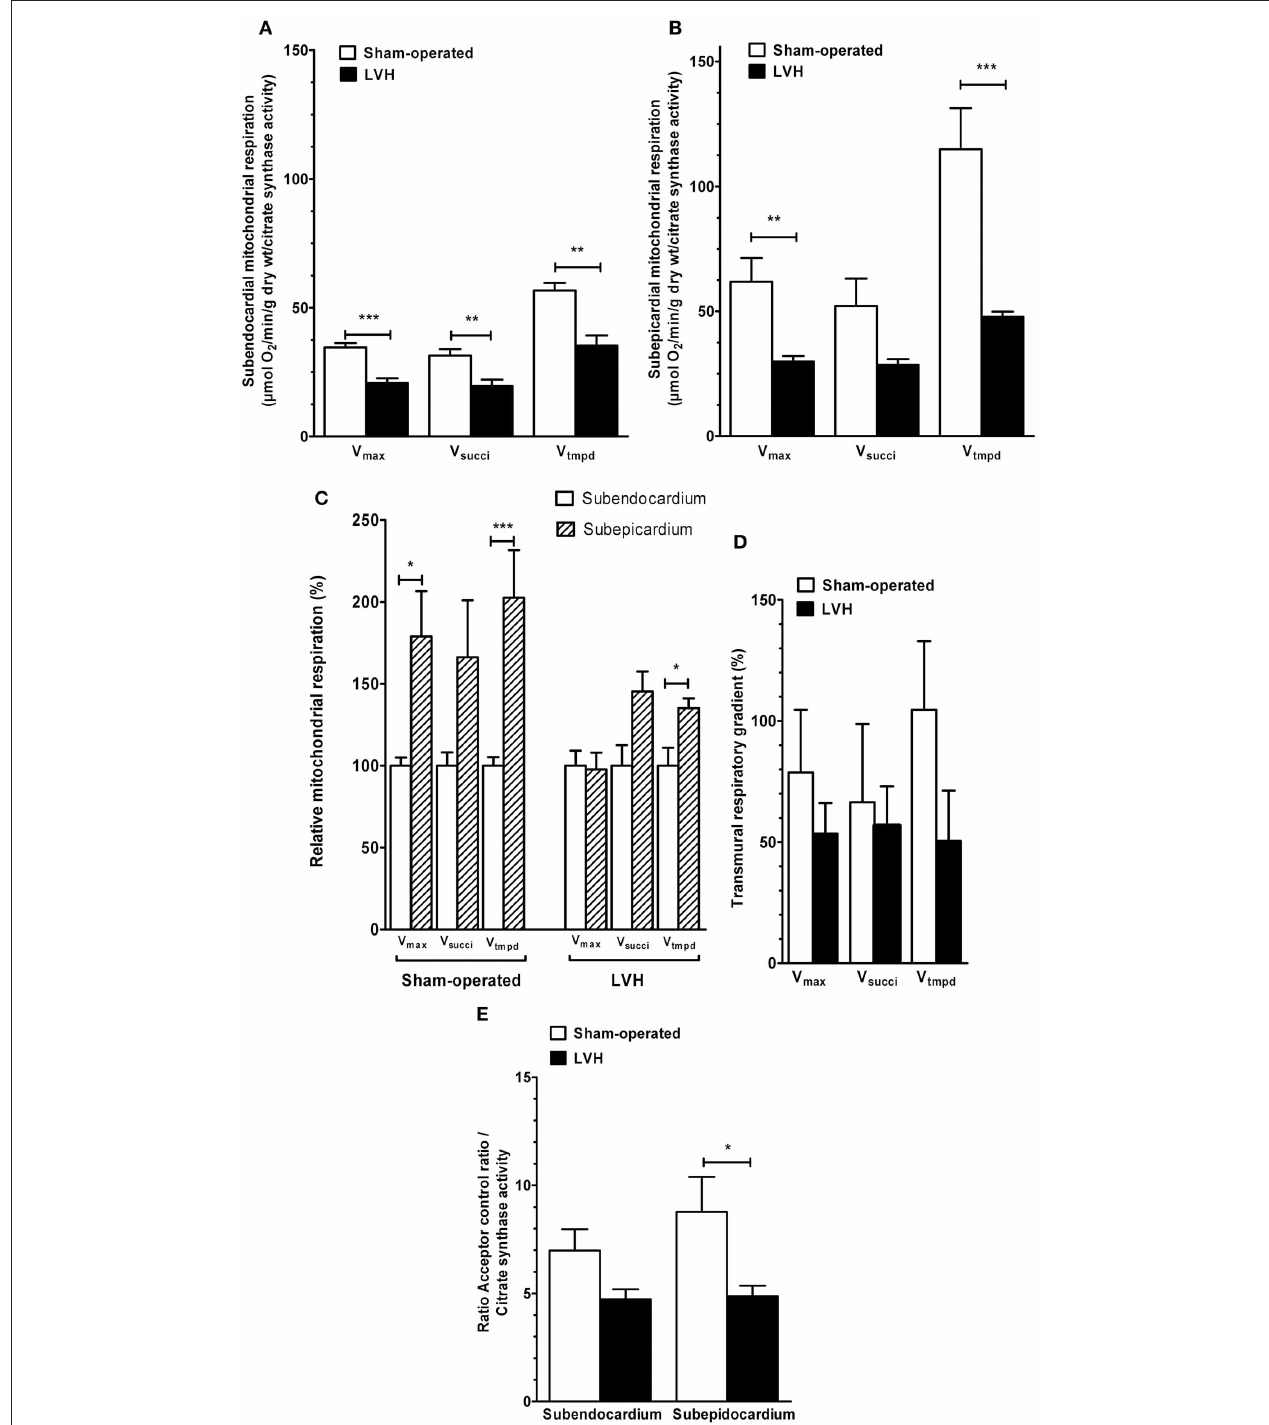
FIGURE 5 | Mitochondrial respiratory chain complex activities and acceptor control ratio in Sham-operated and LVH groups, normalized on citrate synthase activity. (A) Normalized subendocardium mitochondrial respiratory chain complex activities. (B) Normalized subepicardium mitochondrial respiratory chain complex activities. (C) Normalized relative mitochondrial respiration in subendocardium and subepicardium, with the subendocardium layer considered as the reference (100%).